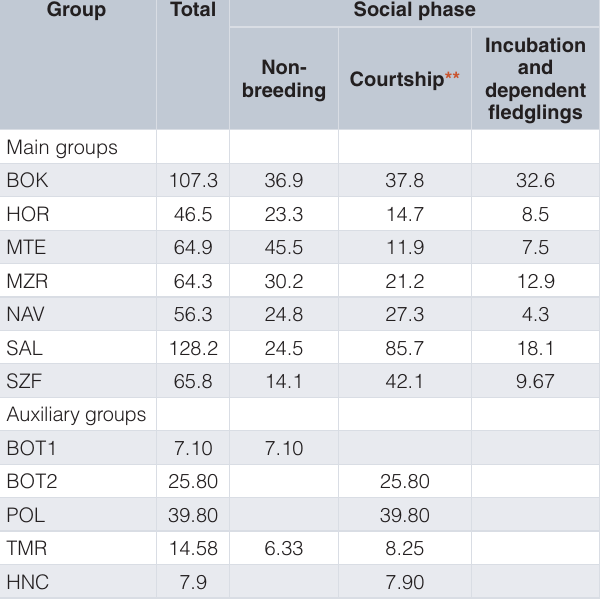
Table 2. Hours of observation* for the different groups: total and at the different social phases. Group